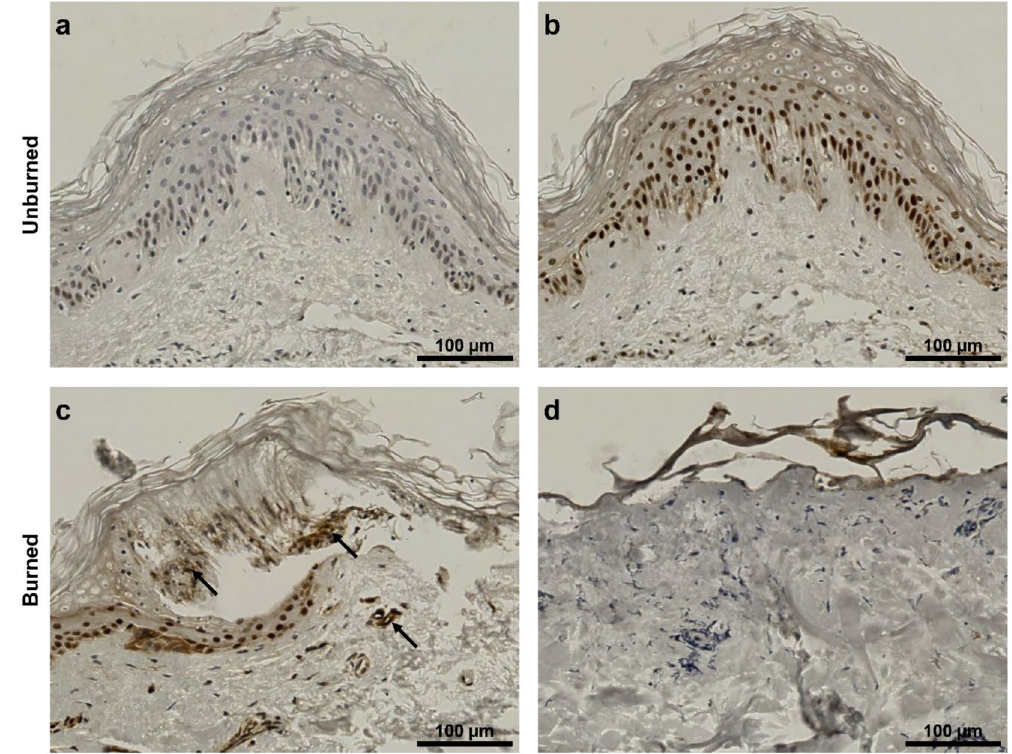
Figure 3. HMGB1 epithelial staining in unburned vs. burned ex vivo skin. Immunohistochemical staining of HMGB1—a marker for tissue viability. The negative control incubated without the primary antibody shows no HMGB1 background signal ( a ). In unburned tissue HMGB1 is localized to the nucleus ( b ). In burned tissue HMGB1 staining is diffuse (( c ), black arrows) or not present anymore ( d ), showing release of HMGB1 due to cell death. Samples (non-debrided, non-infected, no neutrophil supplementation) were fixed on day 6 after burning. For number of skin donors and technical replicates see Table S1. Representative images are